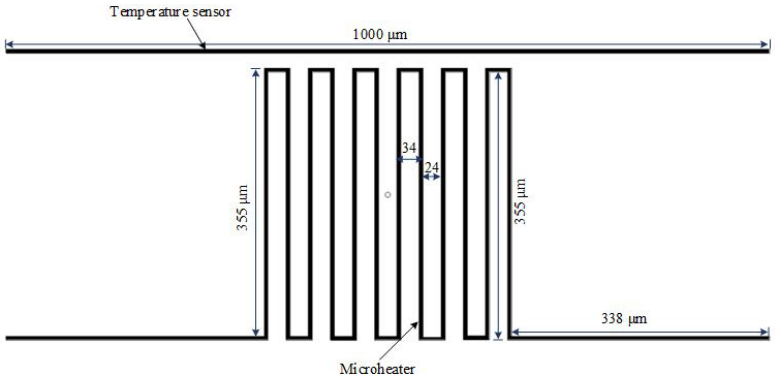
Figure 3. Structure and dimension of the micro-heater and the temperature sensor. Table 2. Dimensions of the micro-heater and the temperature sensor of PolyMUMPs